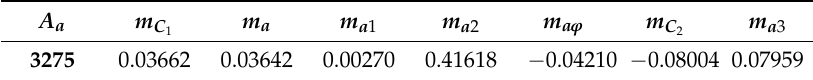
Table 2. Model coefficients of HS a function.